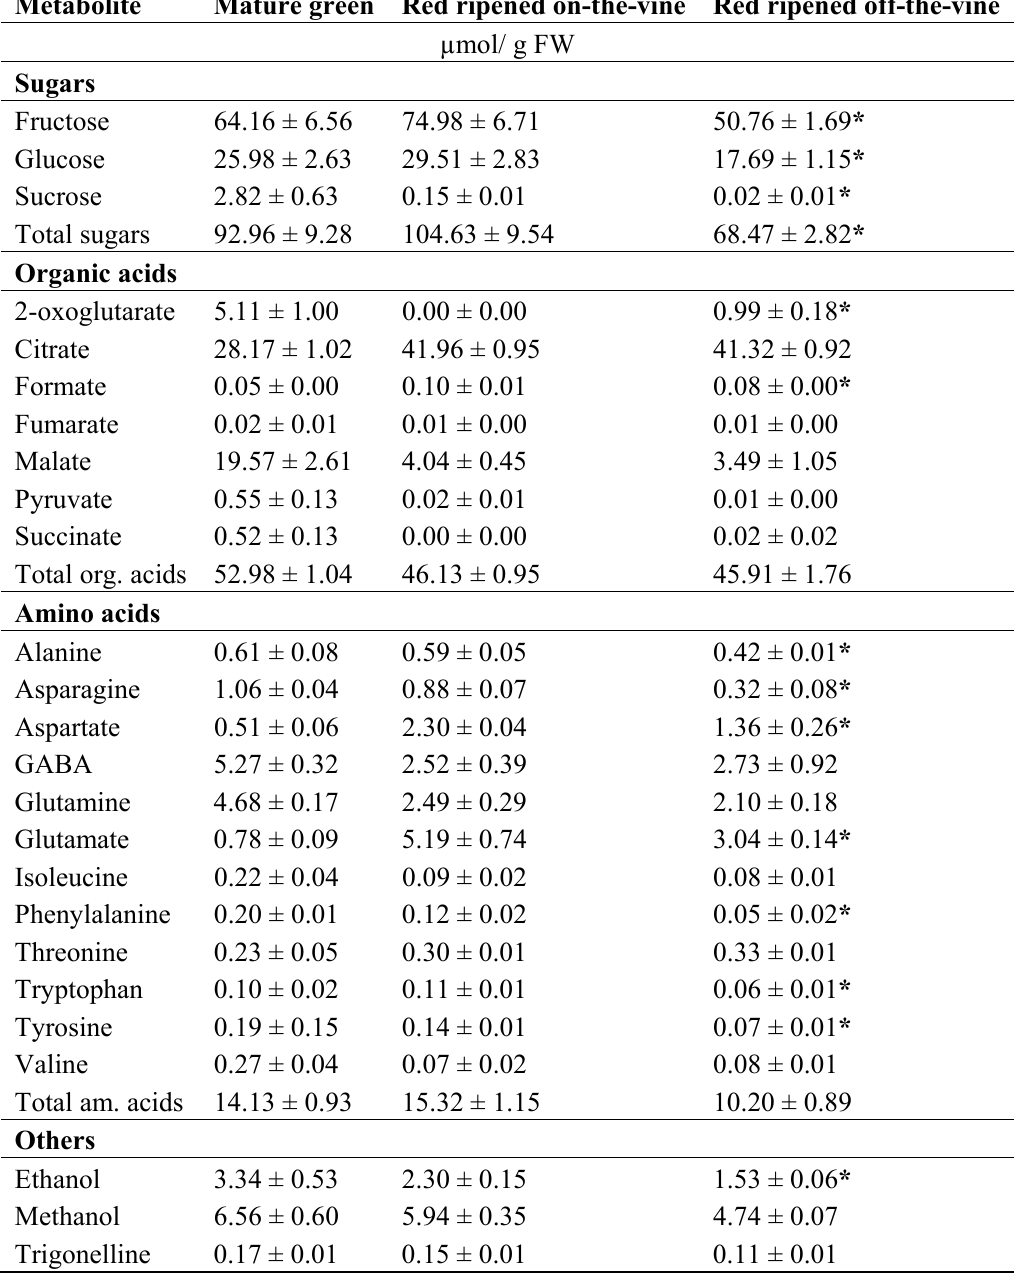
Table 1. Metabolic composition of Micro-Tom mature green and red fruits ripened on- and off-the-vine. Results are presented as means of six independent experiments ± SE. Experimental data were subjected to analysis of variance (ANOVA) test ( p <